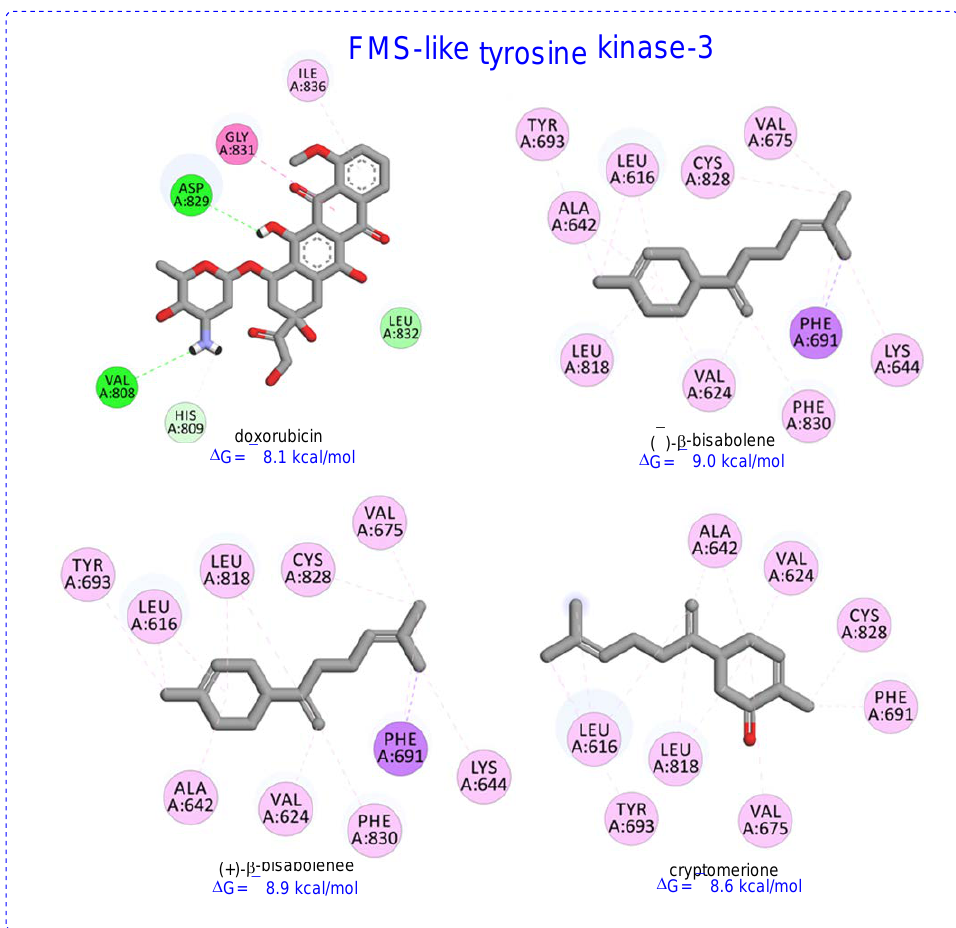
Figure 3. Main interactions observed for doxorubicin (positive control) and the top-scored inhibitors of FMS-like tyrosine kinase-3 (4RT7) by docking analysis.